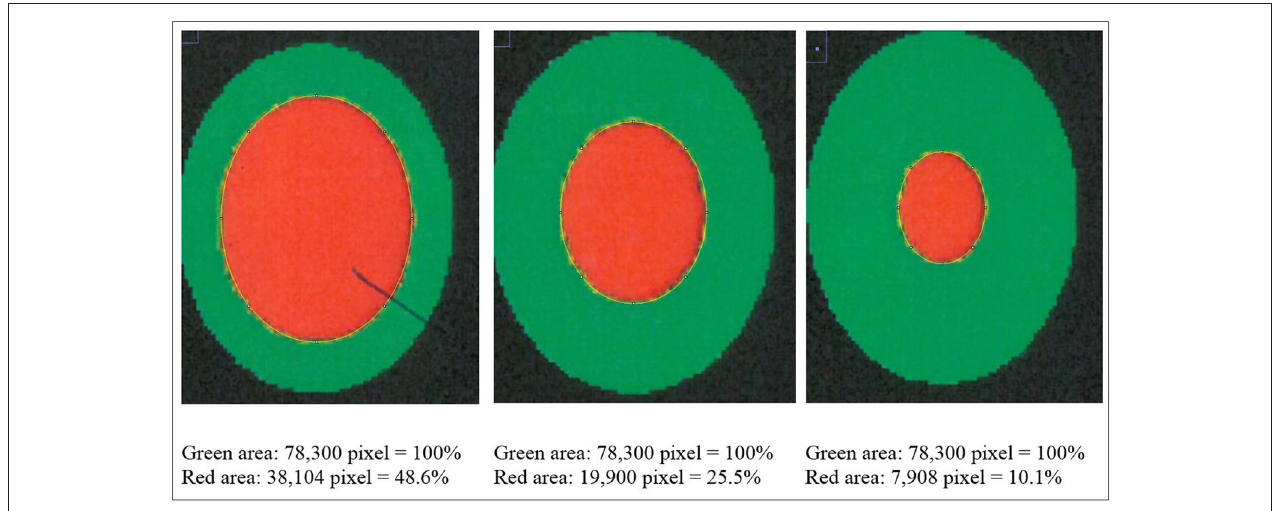
FIGURE 2 | Surface ratio green = foot pad, red = necrosis, fine yellow frame presents manually marked area; output number of pixels by ImageJ